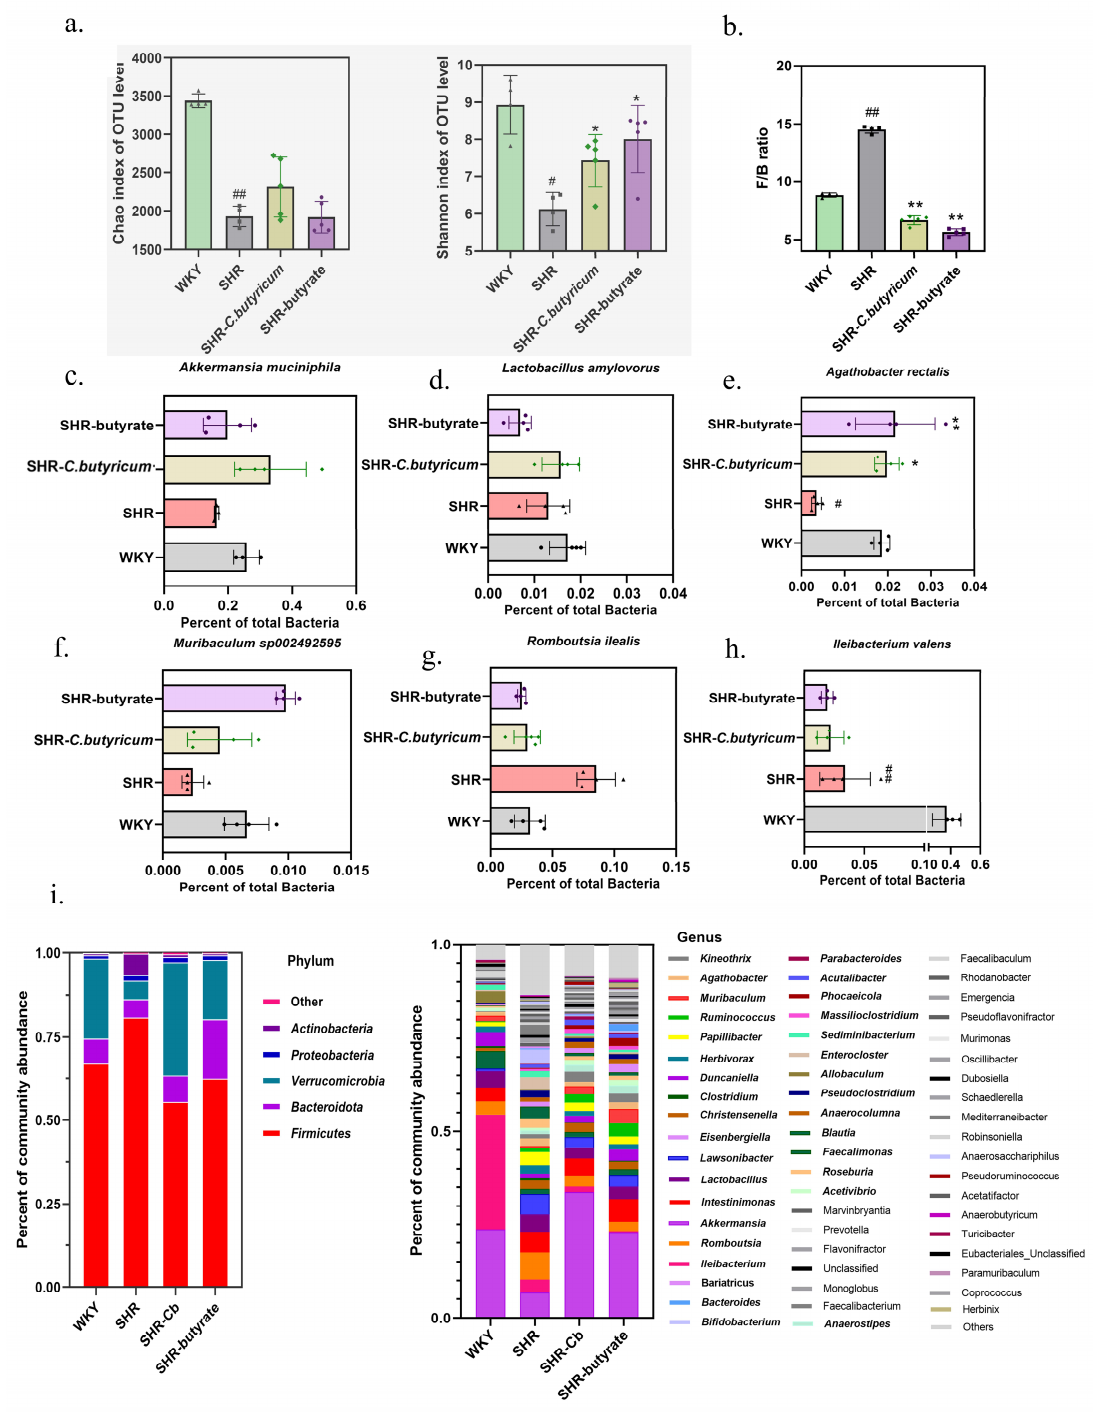
Figure 2. C. butyricum and butyrate alter the composition of the intestinal microbiota. ( a ) 16S rDNA V3 – V4 sequencing to evaluate Chao richness and Shannon diversity. ( b ) The Firmicutes / Bacteroidetes ratio was calculated as a biomarker of intestinal flora dysbiosis. ( c – h ) Relative abundance of Akker- mansia muciniphila , Lactobacillus amylovores , Agthobacter rectails , Muribaculum sp002492595, Romboutsia ilealis , and lleibacterium valens . ( i ) The colors of community abundance percentage plots represent the relative percentage of microbial families assigned to each group. Data are shown as the mean ± S.E.M. n = 4 (WKY, SHR) or 5 (all other groups) for a and c, n = 4 for all groups in c to h, * p < 0.05, ** p < 0.01 for SHR vs. SHR- C. butyricum or SHR-butyrate. # p < 0.05, ## p < 0.01 for SHR vs. WKY.